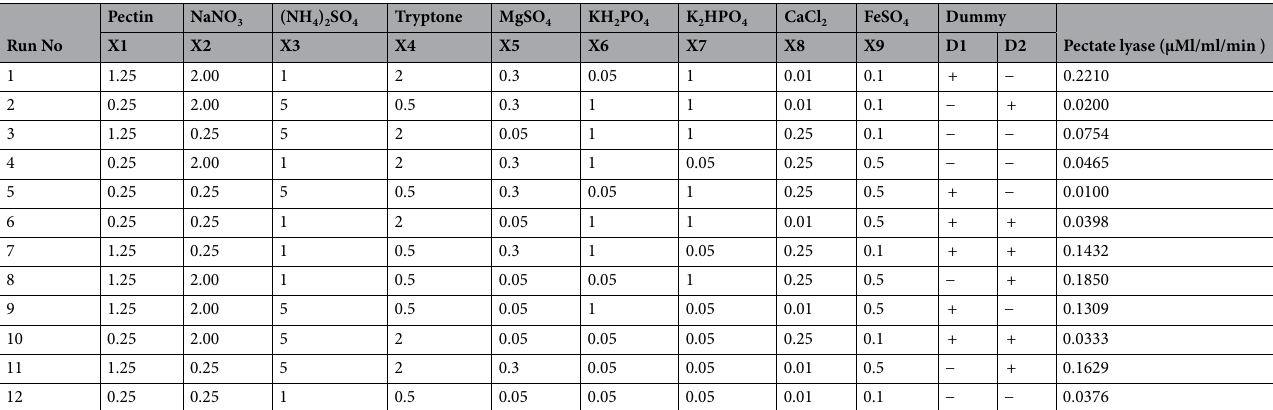
Table 5. Plackett–Burman design matrix where X1, X2…..X9 indicate a number of variables chosen for the study and D1, D2 are dummies for the 12 runs multifactorial design.